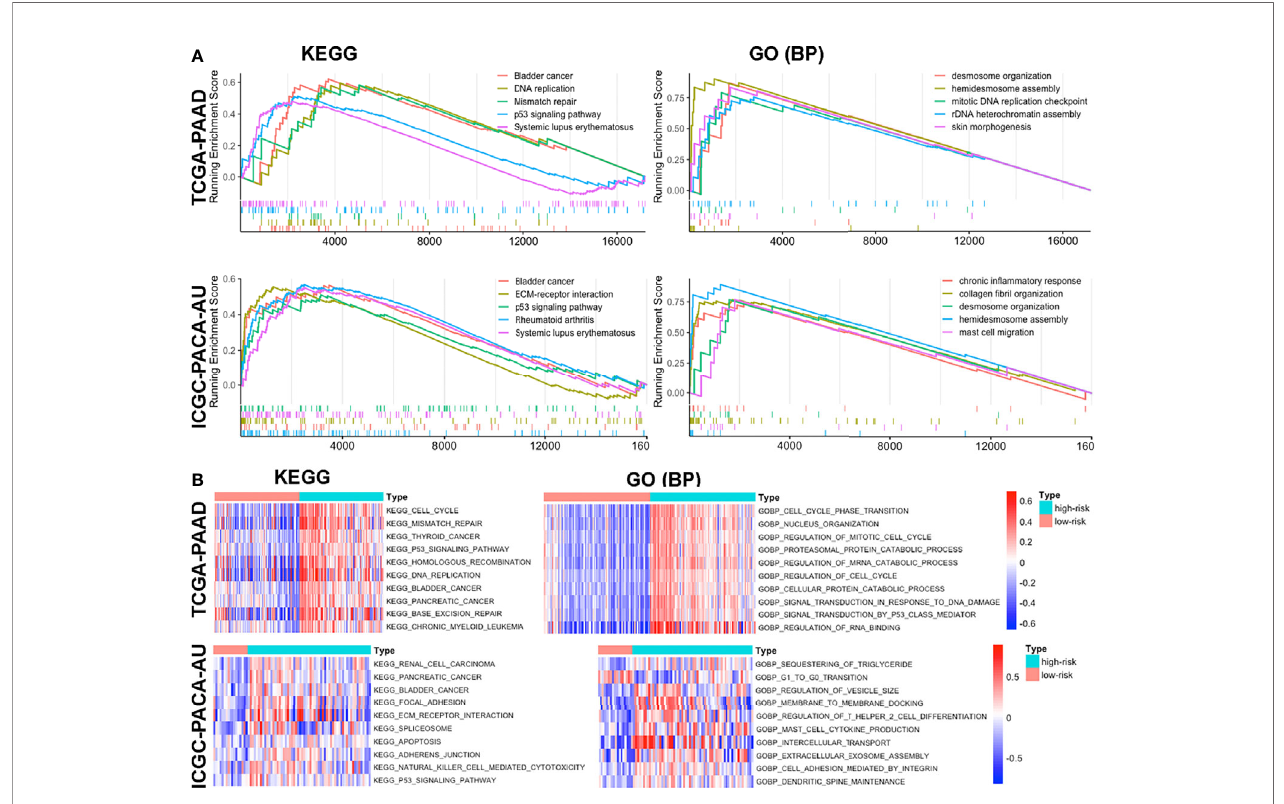
FIGURE 6 | Functional enrichment of the signature based on GSEA (A) and GSVA (B) in TCGA-PAAD and ICGC-PACA-AU